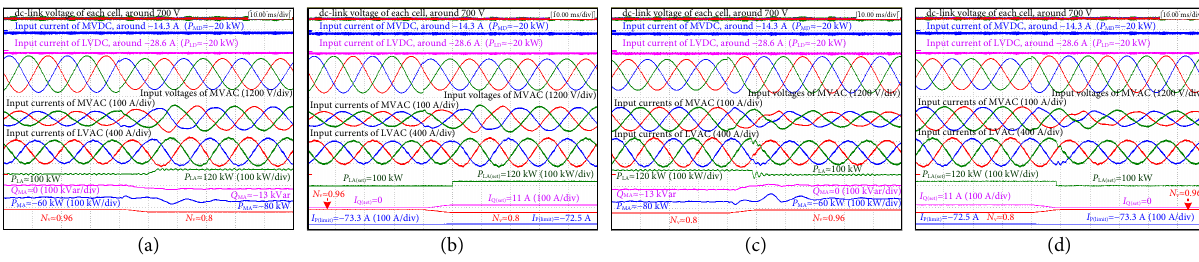
Fig. 21 Experimental results of LVRT Mode-2 in Case-3 of active-power configuration. (a) Real-time power curve in the voltage sag process. (b) Power command curve in the voltage sag process. (c) Real-time power curve in the voltage recovery process. (d) Power command curve in the voltage recovery process. dc-link voltage of each cell, around 700 V Input current of MVDC, around −42.8 A ( P MD ≈−60 kW) Input current of LVDC, around −28.6 A ( P LD ≈−20 kW)